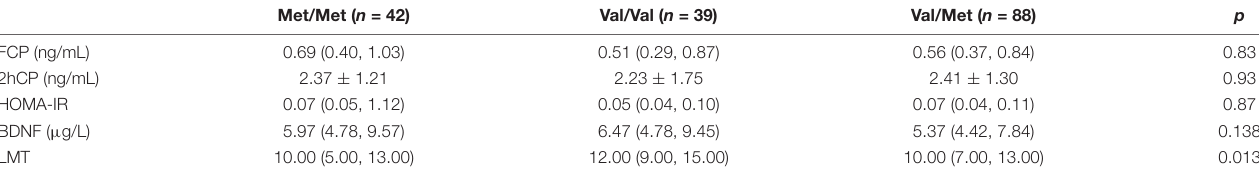
TABLE 6 | Comparison of plasma BDNF level, LMT, insulin secretion, and resistance between genotypic